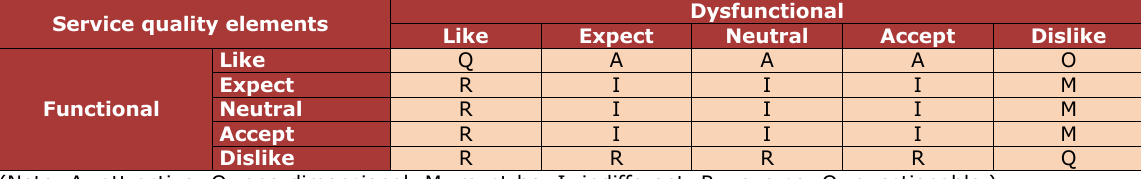
Table 1. Kano evaluation